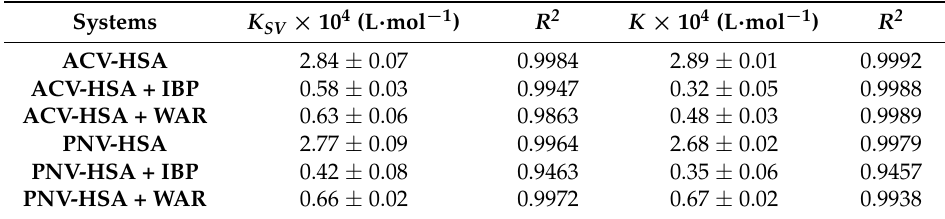
Table 4. Estimated Stern–Volmer constants for ACV/PNV with HSA, in the presence and absence of site markers.